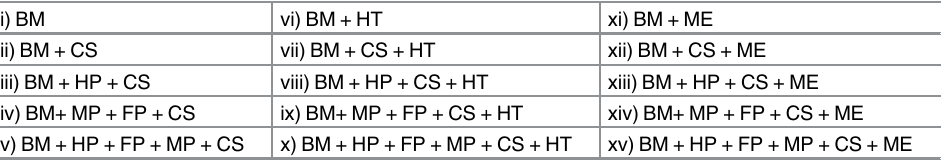
Table 2. Summary of variables included in GEE models used to predict clutch volume analyses.